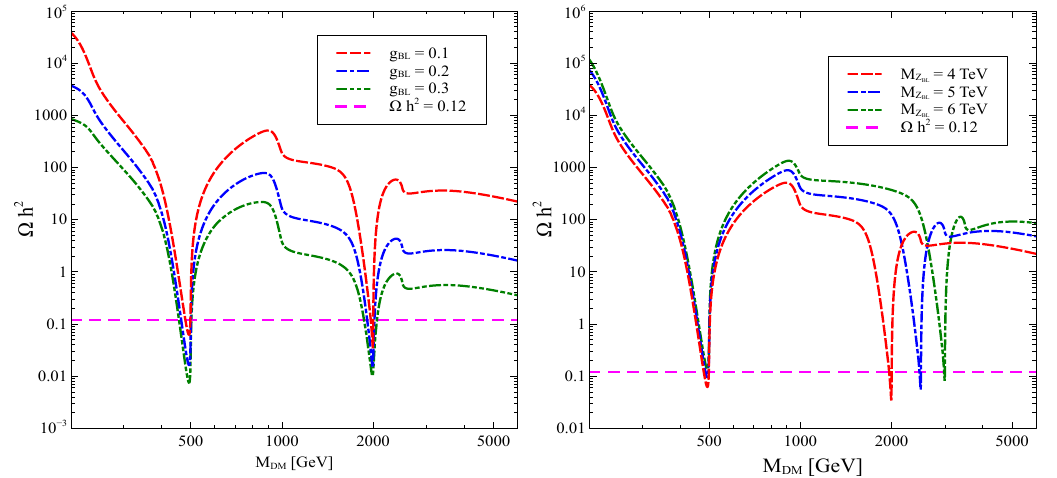
Figure 7 . Left (right) panel: variation of relic density with the DM mass for three di(cid:11)erent values of gauge coupling (gauge boson mass). While other BSM parameters have been kept (cid:12)xed at r vev = 5, M N = M N 0 = 361 : 4 GeV, M N = M N 0 = 296 : 2 GeV, M N = M N 0 = 111 : 0 GeV, 1 2 3 1 2 3 M h = 1000 : 0 GeV, M h = 250 GeV, M Z ( g BL ) = 4000 (0.1) GeV, h e(cid:22) = 1 : 58, h e(cid:28) = 1 : 63, 2 3 BL h (cid:22)e = 2 : 38, h (cid:28)e = 1 : 34, sin (cid:12) = 0 : 07, (cid:1) M = M 2 M 1 = M 2 M DM = 50 GeV. (cid:0) (cid:0)